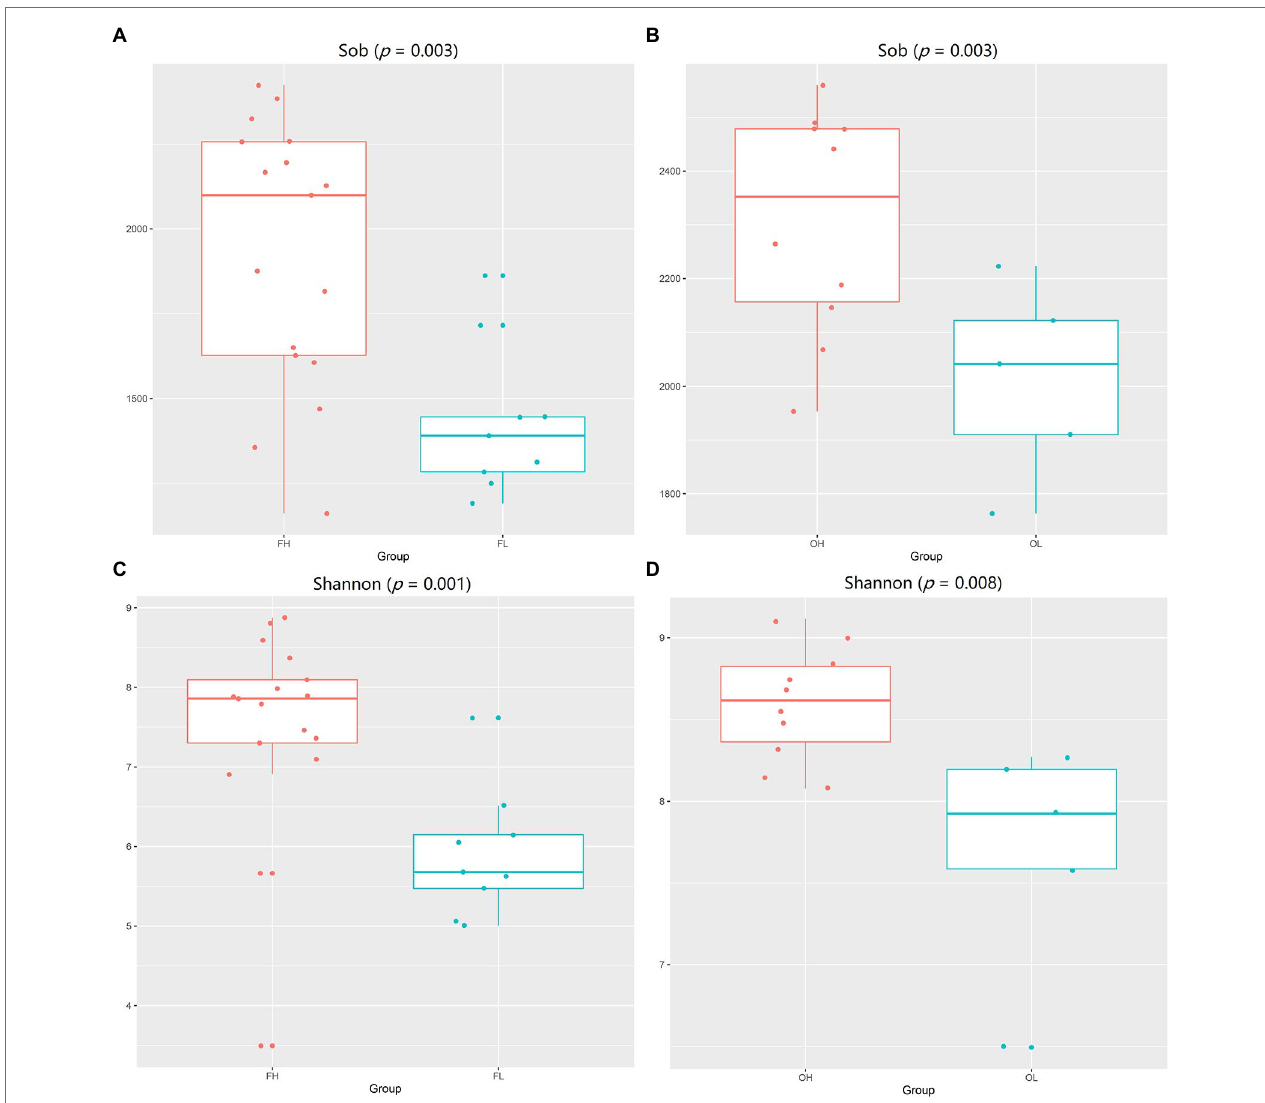
FIGURE 6 | Wilcoxon’s test of alpha-diversity (Sobs and Shannon index) of gut microbiome between groups. (A) Sob index of group FH vs. group FL; (B) Sob index of group OH vs. group OL; (C) Shannon index of group FH vs. group FL; (D) Shannon index of group OH vs. group OL. FH, high-altitude Artiodactyla (including groups HB, HT, and HY); FL, low-altitude Artiodactyla (including groups LB and LY); OH, high-altitude Perissodactyla (group HA); OL, low-altitude Perissodactyla (group